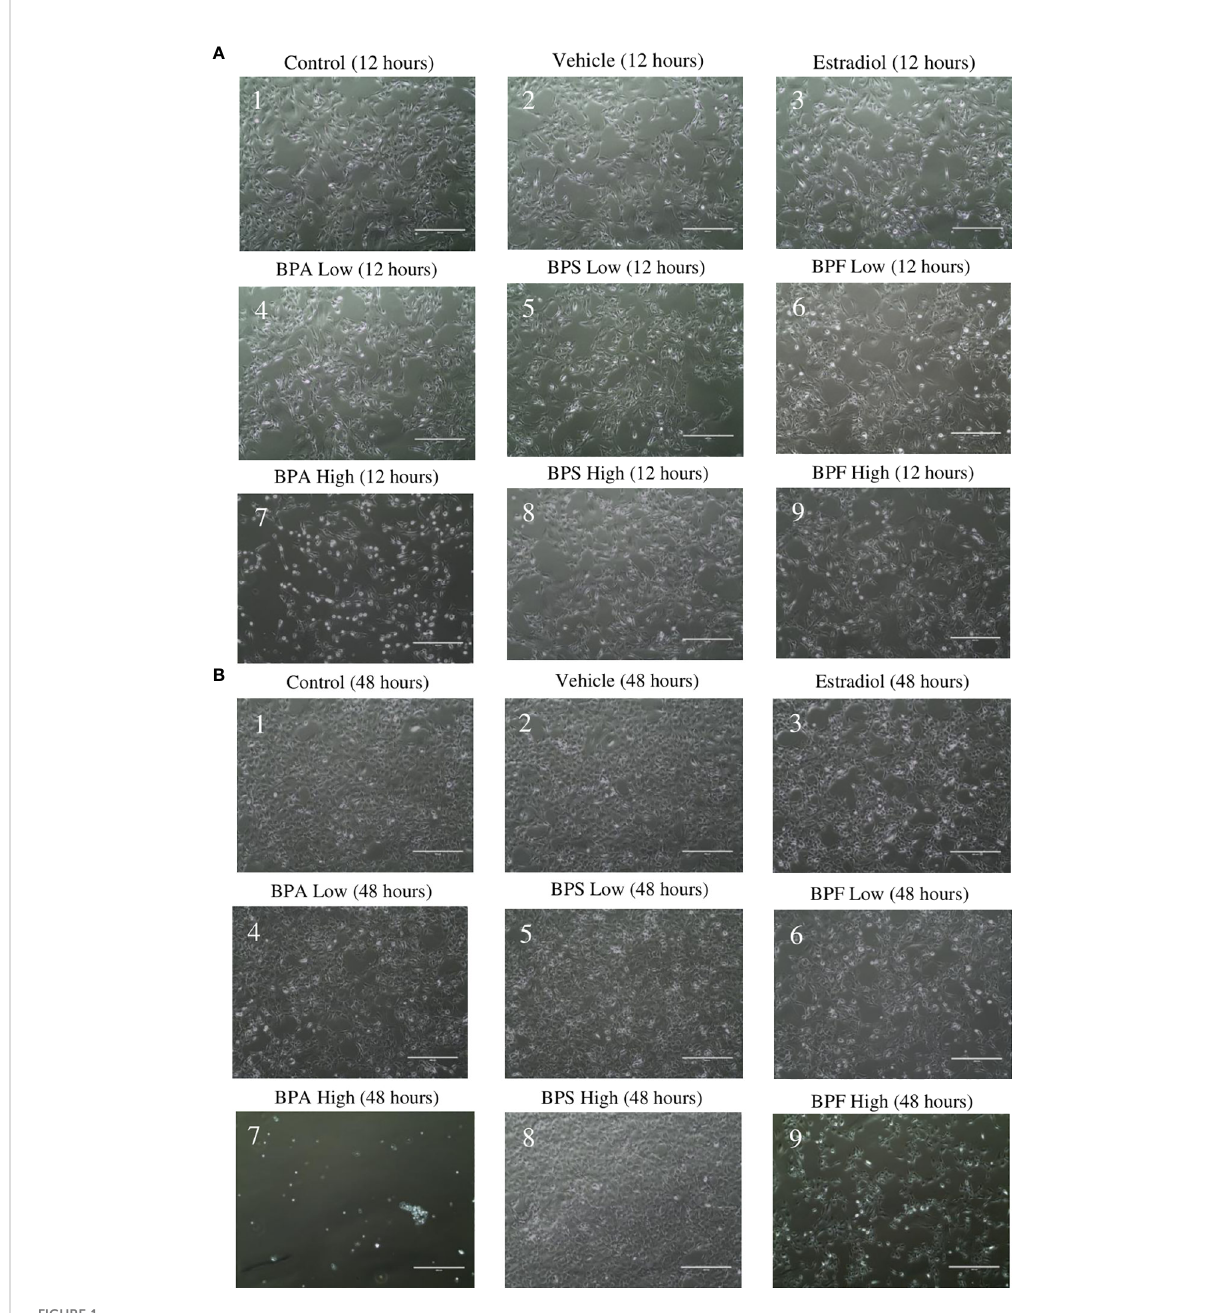
FIGURE 1 Granulosa cell morphology. After 12 hours (A) and 48 hours (B) of treatment with environmentally signi fi cant doses of bisphenols (A, S, F). Images were taken using the ThermoScienti fi c EVOS digital inverted microscope at 10x magni fi cation. Scale bar=1000 m